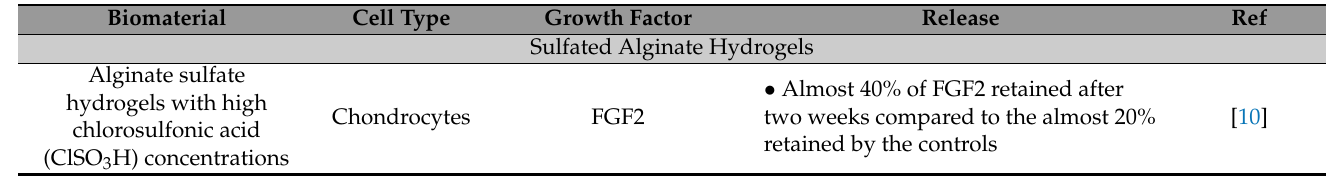
Table 1. Sulfated hydrogels for sustained release of growth